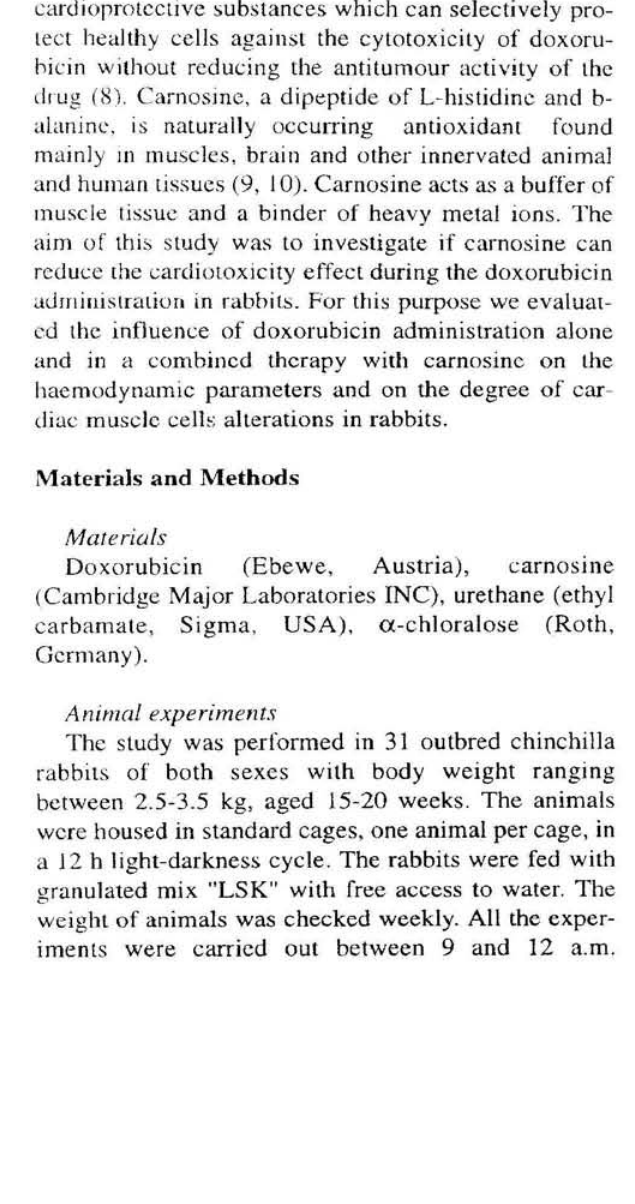
Number of Group Drugs Single doses rabbits